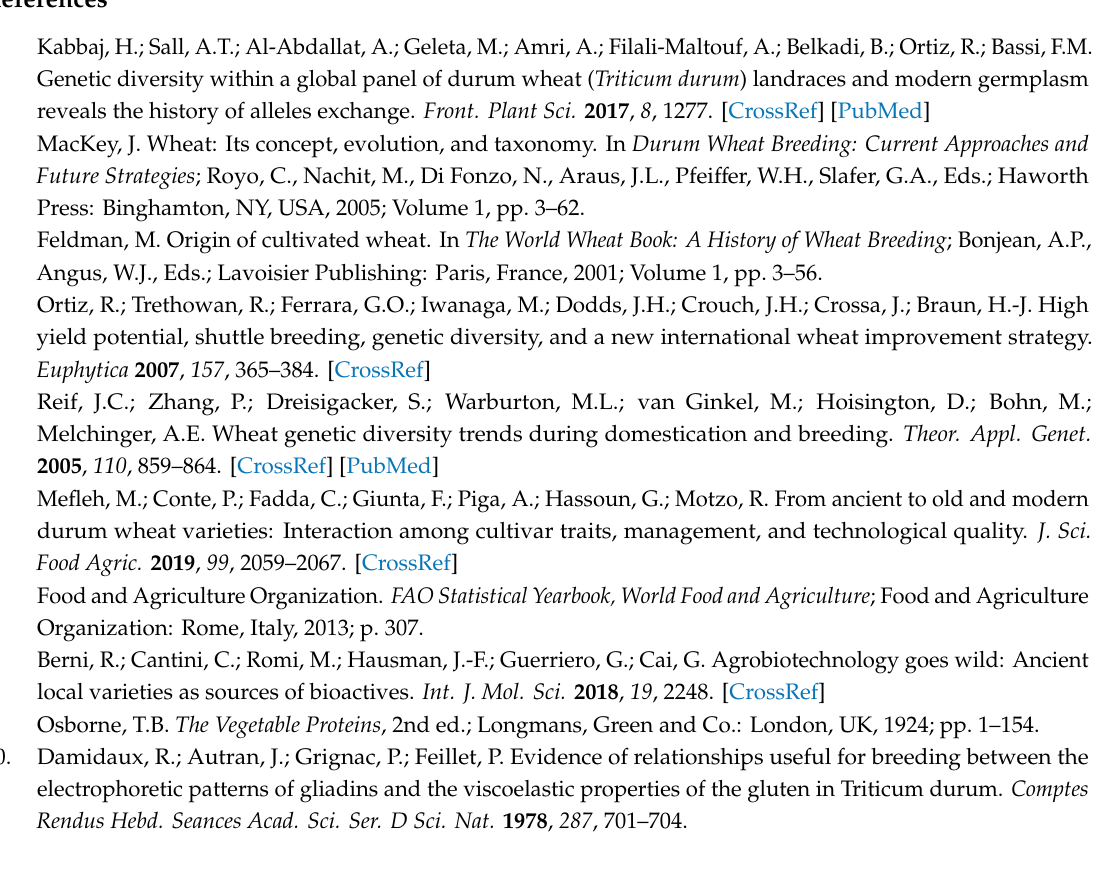
Figure S1: MALDI-TOF mass spectrum for the Spanish landrace with the 20x subunit at locus Glu-B1 (BGE 021769), Table S1: CRF gene-bank code and local name of the 116 durum wheat Spanish landraces analyzed. Their allelic pattern for the prolamin loci studied and data for the quality variables examined is included. The BGE number of the landraces that could not be analyzed in 2015 is in red lettering, Table S2: Pearson’s correlation tests to analyze the relation between protein content and SDS sedimentation volume values obtained in 2012 and 2015, and between the quality traits examined, Table S3: Mean squares (MS) and F-values as determined by ANOVA showing the e ff ect of the prolamin loci on grain protein content, SDS sedimentation volume and mixograph parameters. The e ff ect of the year and G × E (year) interactions is also considered for protein content and SDSS-test values, Table S4: Mean squares (MS) and F-values as determined by ANOVA showing the e ff ect of the prolamin loci on protein content, SDS sedimentation volume and mixograph parameters if the four landraces bearing the Glu-A1o allele are excluded from the analyses. The e ff ect of the year is also considered for protein content and SDSS-test